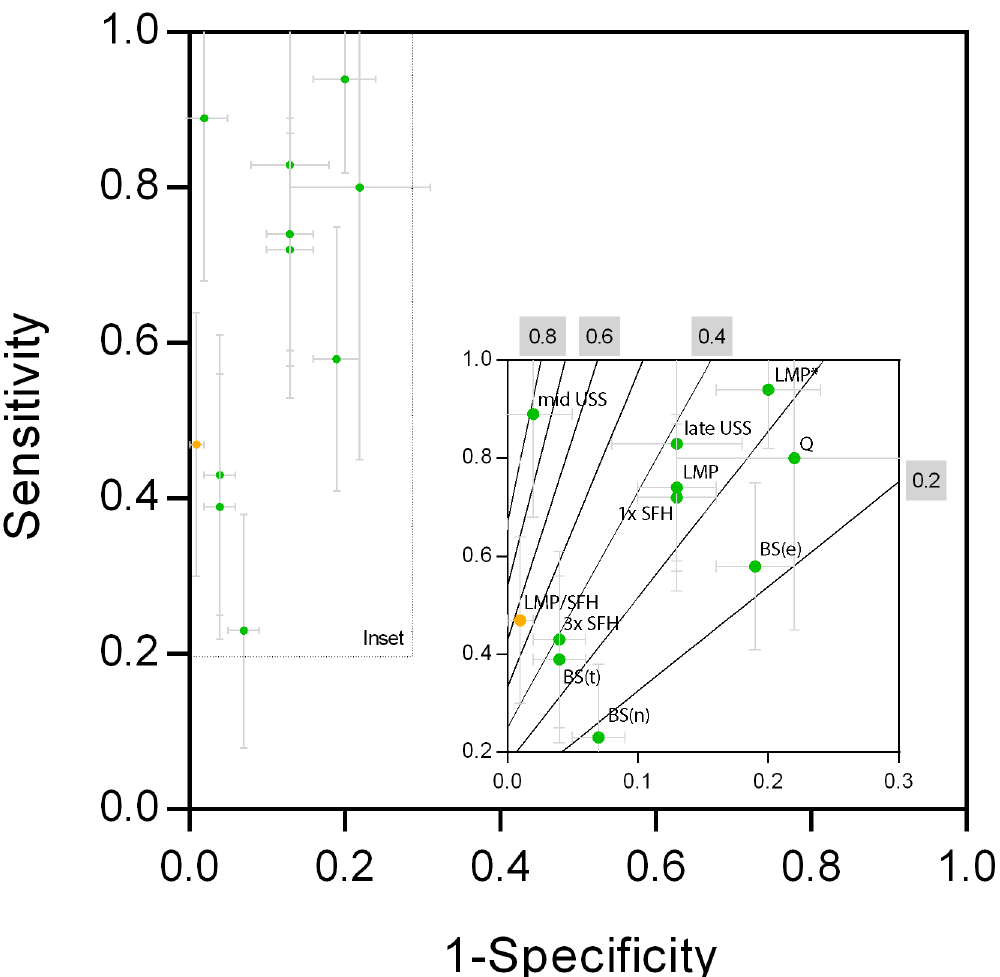
Fig 4. Receiver Operating Characteristic Space for Mid- and Late-Pregnancy USS and Clinical Estimators to Predict PTB. Note that the insets are magnifications of the regions of interest (outlined by the dotted lines). The solid gray lines with gray numbering are the F-measure isolines in the receiver operating characteristic space. BS(e): external BS; BS(n): neuromuscular BS; BS(t): total BS; LMP: last menstrual period; mid-scan: mid-pregnancy USS; late-scan: late-pregnancy USS; 1x SFH: linear SFH model; 3x SFH: sequential SFH model; LMP/SFH: LMP/SFH model; LMP * : corrected LMP according to PNG